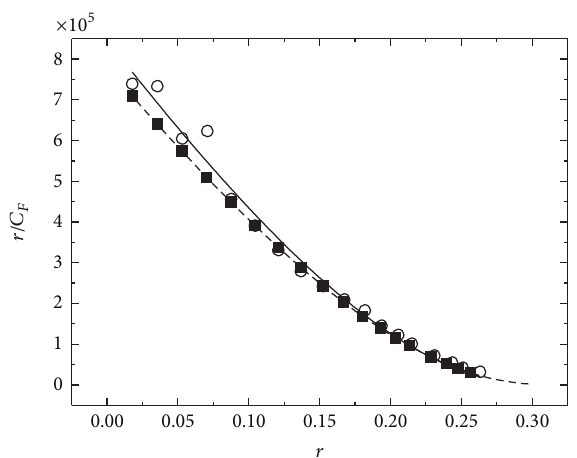
Figure 9: Scatchard plot of Daun-DNA binding. The squares and circles show SVD-based fitting and a traditional Scatchard plot, respectively. The standard noncooperative McGee and von Hippel model fitting parameters are 𝐾 = 8.5 ± 0.2 × 10 5 M −1 and 𝑛 = 3.14 ± 0.06 bp/(bounddrugmolecule)whiletheSVD-basedparametersfor fitting are 𝐾 = 7.79 ± 0.05 × 10 5 M −1 and 𝑛 = 3.0 bp/(bound drug molecule).